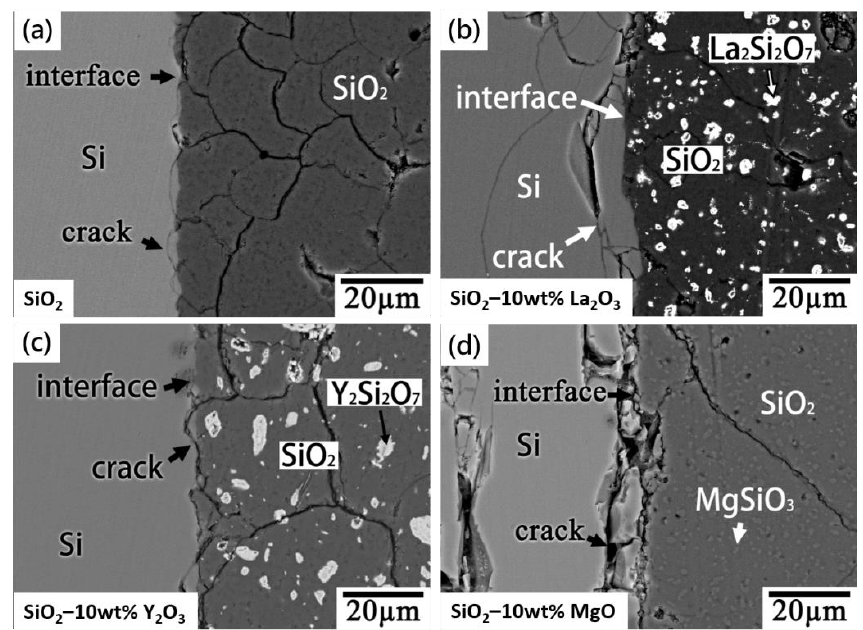
Figure 6. BEIs/SEM images of ( a ) Si/SiO 2 , ( b ) Si/SiO 2 – 10 wt.% La 2 O 3 , ( c ) Si/SiO 2 – 10 wt.% Y 2 O 3 , and ( d ) Si/SiO 2 – 10 wt.% MgO interfaces.